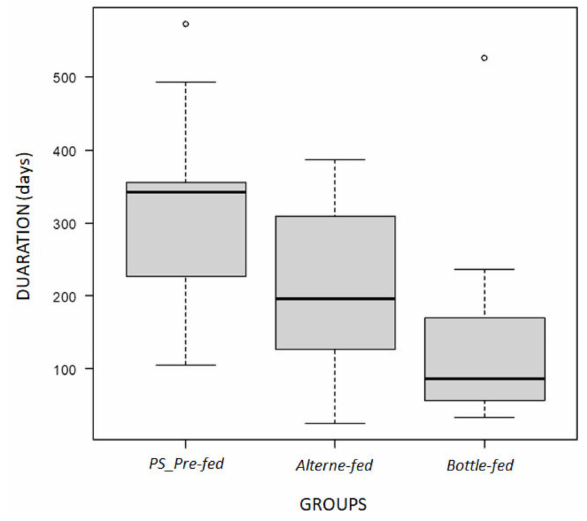
Figure 2. Breastfeeding duration in PKU patients who received HM with different